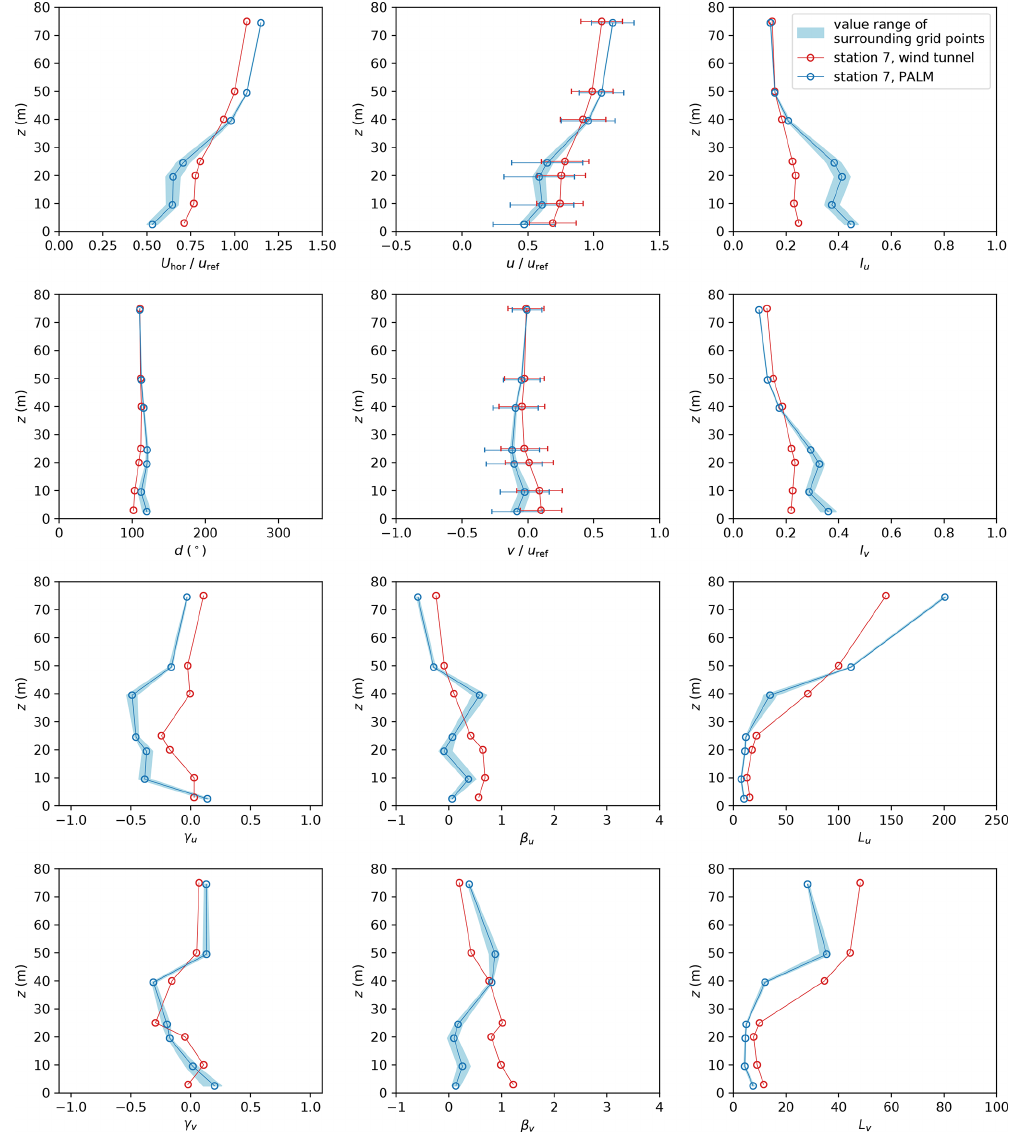
Figure 13. Profiles of mean horizontal wind speed U hor , wind direction d , and wind components u and v as well as turbulence intensity I , skewness γ , excess kurtosis β , and length scale L of both wind velocity components u and v at measurement station 7. Error bars denote the standard deviation of the respective quantity. Note that z = 0 denotes street-level